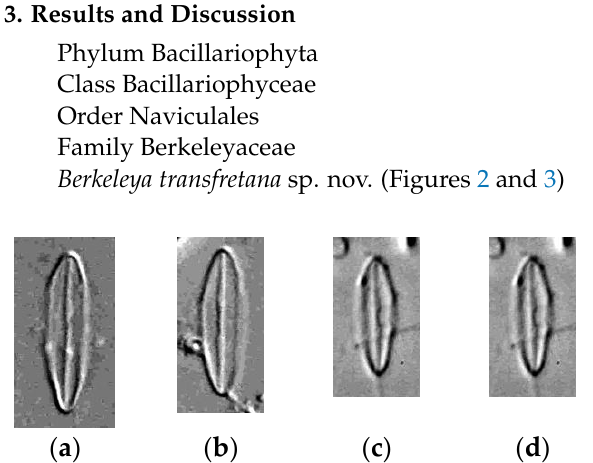
Table 1. Diagnostic features of B. transfretana and similar species.